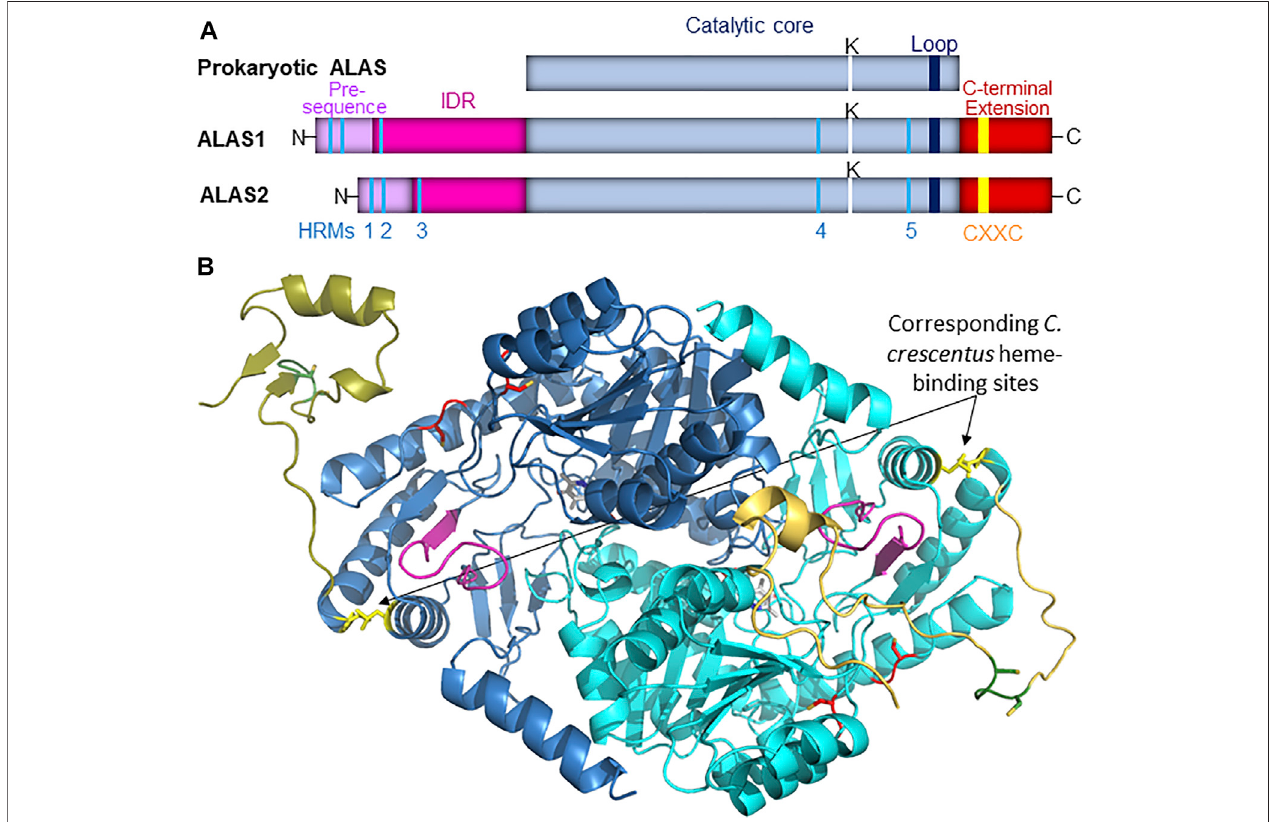
FIGURE 1 | (A) . Schematic representation of ALAS monomeric structure. In vertebrate species the ALAS gene is duplicated, and the protein catalytic core (light blue) observed in prokaryotes is bracketed by extended N- and C-termini. The mitochondrial targeting sequence is illustrated in light purple, while the intrinsically disordered N-terminal extension (IDR) is in magenta, and the C-terminal extension is in dark red. Five conserved Heme Regulatory Motifs (HRMs, colored in cyan) are conserved in vertebrate ALAS isozymes, as is a CXXC motif (yellow) in the extended C-terminus. The position of the active site lysine residue that binds PLP in the active site isdenoted byawhiteline,and theloopthat gates theactive site isrepresented byadark blue line. (B) .The position corresponding tothe heme-bindingsite in C. crescentus ALAS modeled into mammalian ALAS2. AlphaFold-predicted structures for human (light blue and gold; AlphaFold entry P22557) and murine (dark blue andgold;AlphaFoldentryP08680)ALAS2werealignedwith R.capsulatus ALAScrystalstructure(PDBcode2bwn;notshown)usingPymol.Themodeledsitedepicted in yellow here is not expected to bind heme in mammals due to evolutionary divergences, and this site is illustrated solely for perspective on its spatial relationship to the mammalian ALAS2 active site loop (purple), the C-terminal extension (shades of gold), and HRMs 4 and 5 (red). Additionally, the CXXC motifs are in green with the cysteines shown as